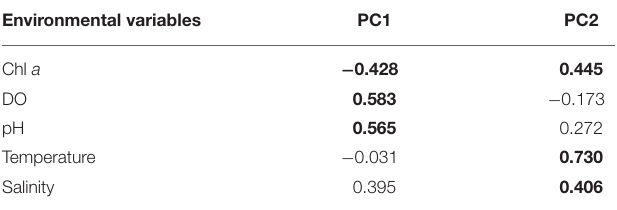
TABLE 2 | Loadings on PC1 and PC2 of Principal Component Analysis of environmental variables across sites and time. Environmental variables PC1 PC2 Chl a − 0.428 0.445 DO 0.583 − 0.173 pH 0.565 0.272 Temperature − 0.031 0.730 Salinity 0.395 0.406